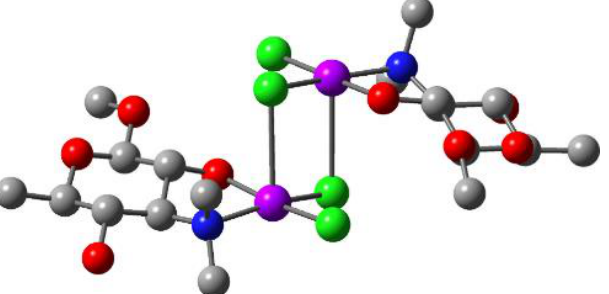
Figure 12. The most favorable structure of the dinuclear green mycaminosyl complex 7 . Hydrogen atoms are omitted for clarity. Colour code: C—grey, O—red, N—blue, Cl—green, Cu—magenta.